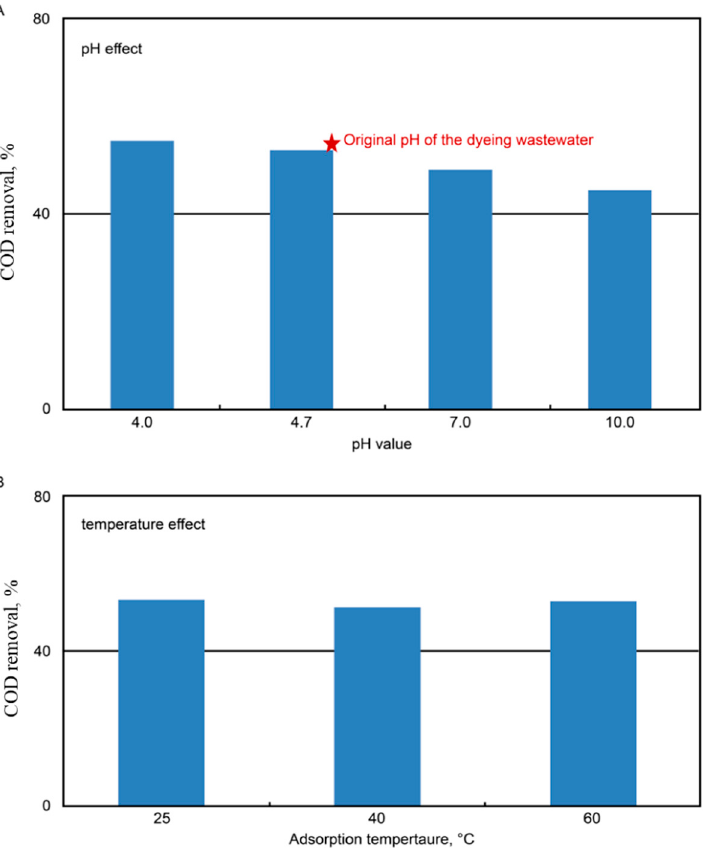
Figure 3. Effects of pH at ambient temperature ( A ) and temperature at pH = 4.7 ( B ) during AC adsorption runs. A lower pH value showed a greater percent COD removal, but the temperature had little effect.